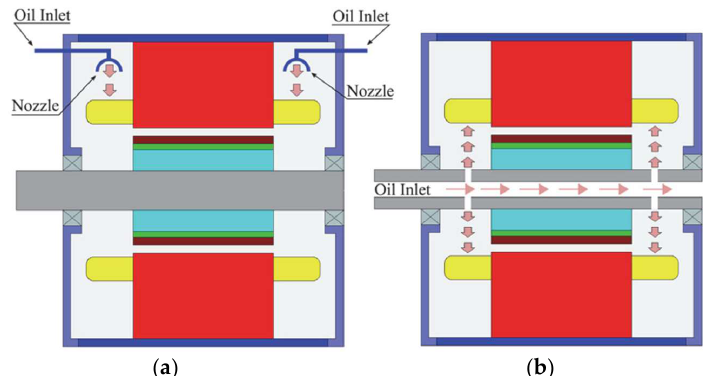
Figure 18. Schematics of oil spray cooling arrangements [43]. ( a ) Oil injected by a single nozzle on top of the end-winding. ( b ) Oil injected through a hollow